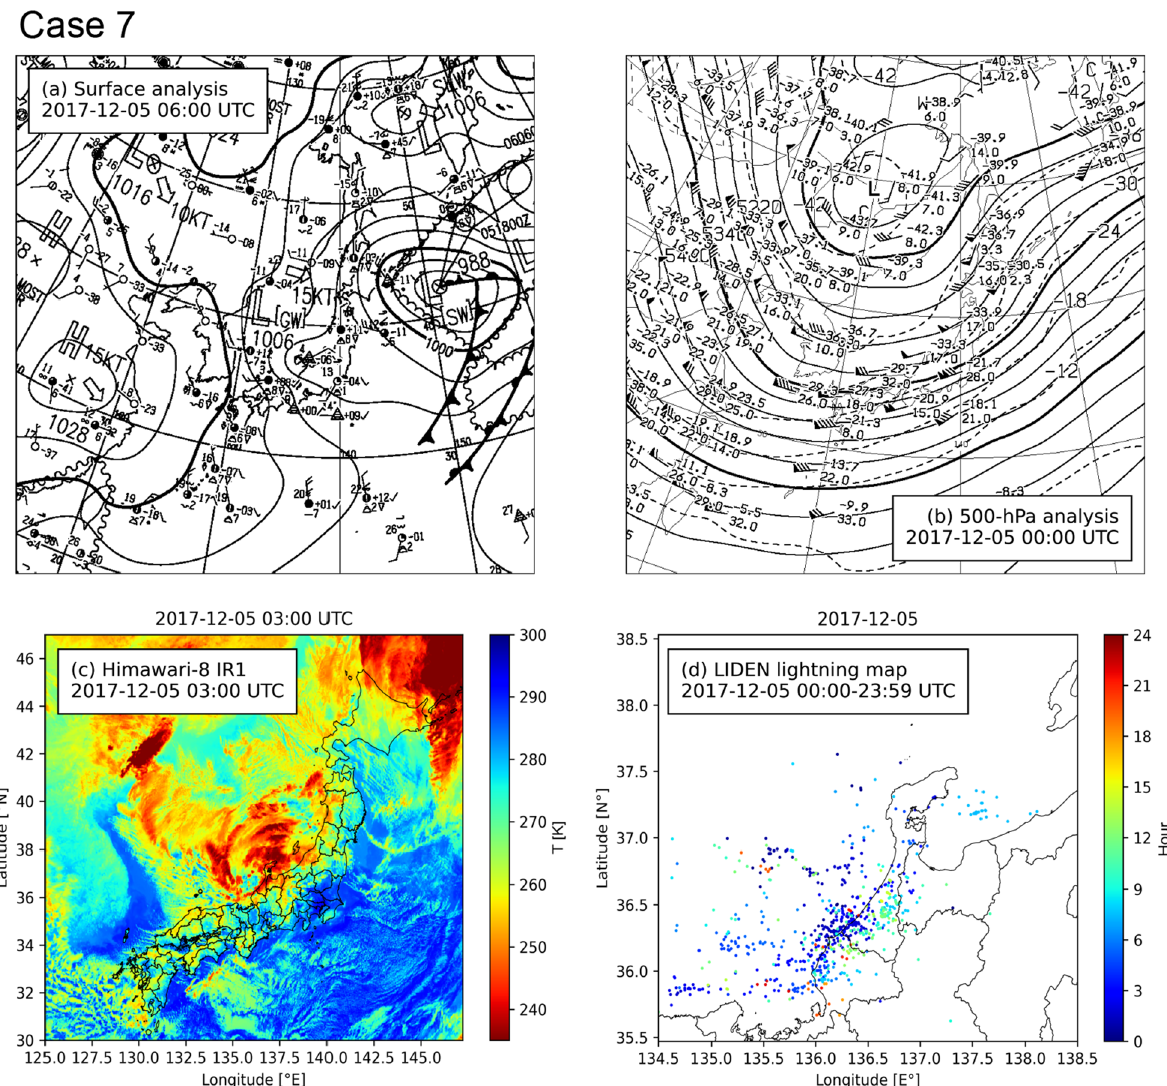
Fig. 8 Meteorological charts of the glow-detection case 7 in the same format as Fig.